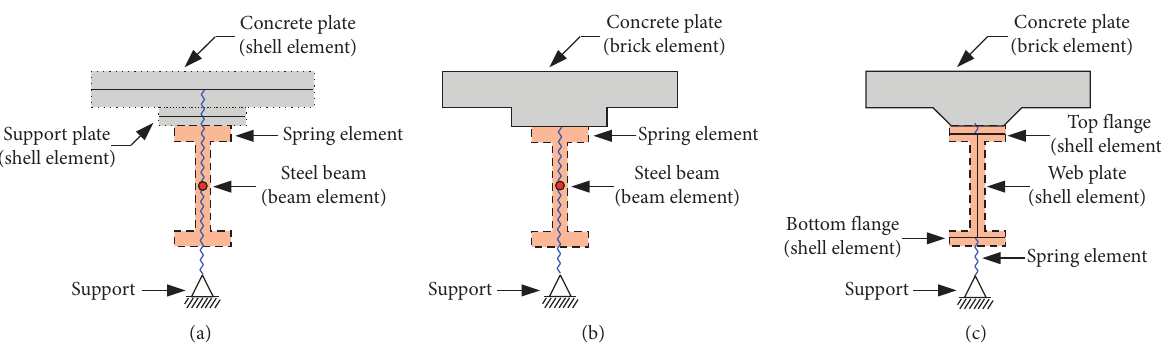
Figure 12: Comparison of the detailed configurations of three FE models: (a) beam-shell element; (b) beam-solid element; (c) shell-solid element.